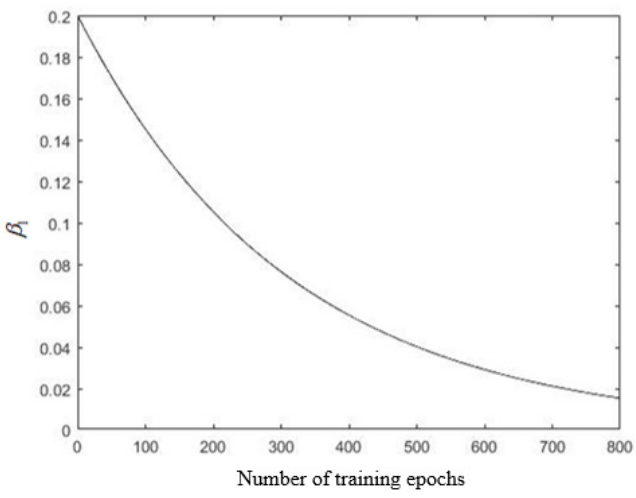
Figure 17. The variation trend of learning rate β 1 .